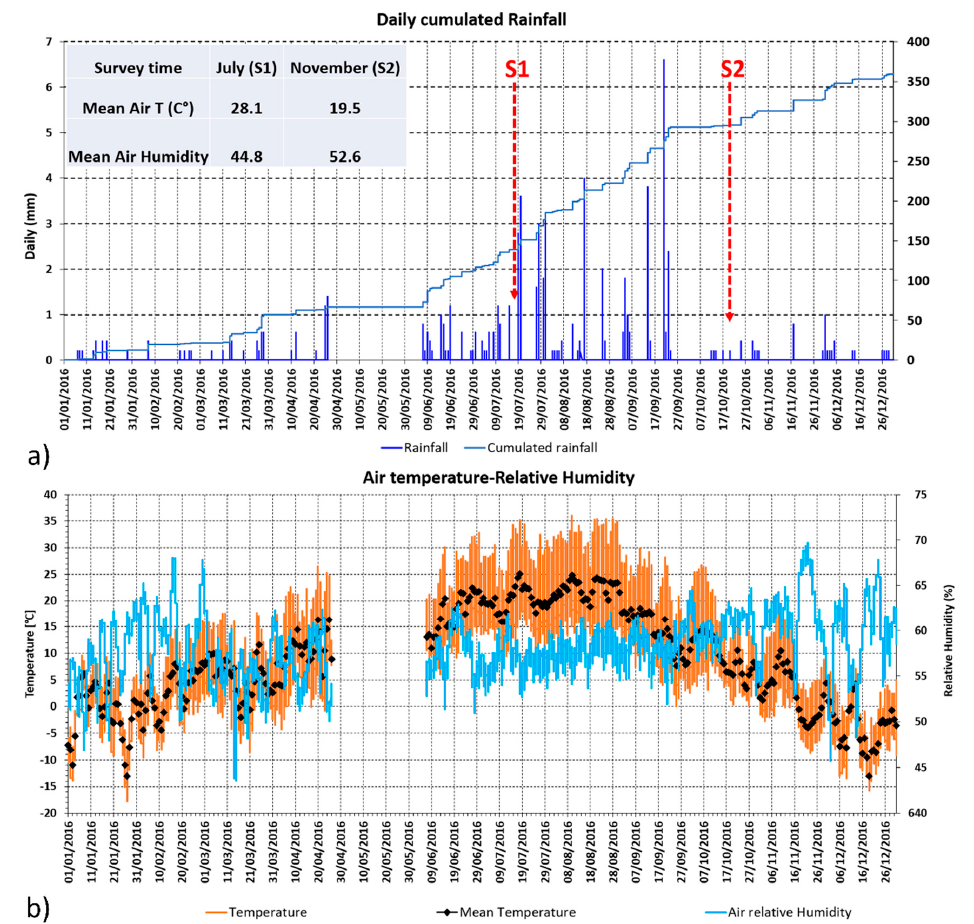
Figure 4. Weather microclimate data recorded by the Weather Station of Vardzia: ( a ) Daily cumulated rainfall recorded during 2016 in Vardzia and weather conditions during IRT surveys S1 and S2, ( b ) Air temperature and relative humidity recorded during 2016.